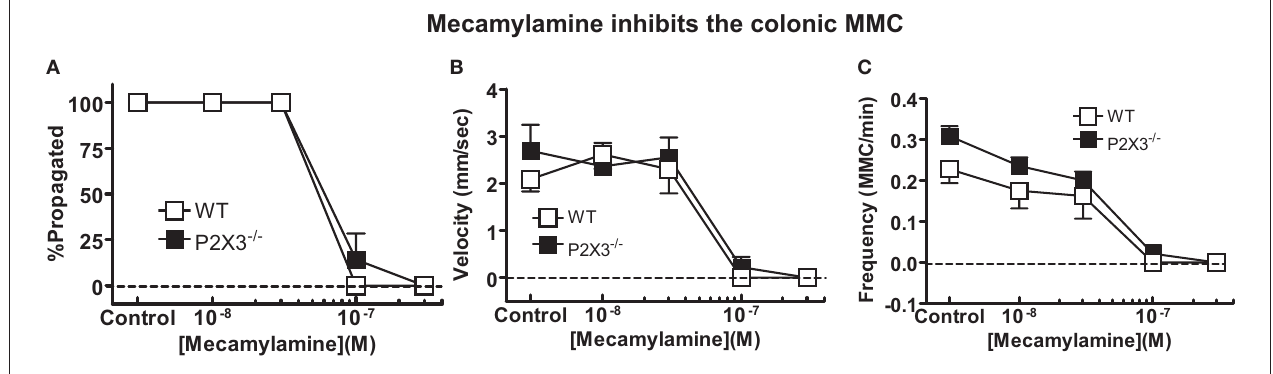
Figure 5 | Mecamylamine caused equivalent inhibition of MMC efficiency of propagation (A), speed of propagation (B) and MMC frequency (C) in isolated colonic segments from WT ( n = 4), and P2X3 ( n = 7) subunit KO mice. Data are mean ± SEM. There were no differences among groups ( P > 0.05) in any of these measures (two-way ANOVA).